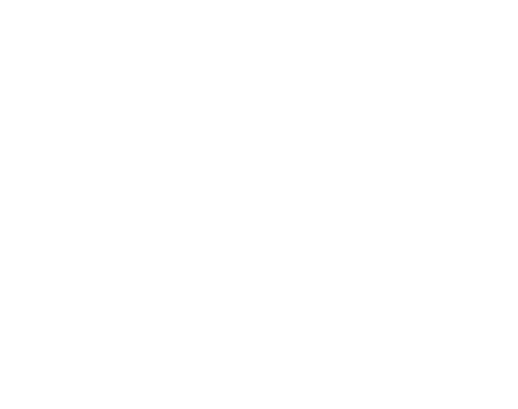
Figure 7. Spearman rank correlations between different parameters of behavioral taste responses to pellets of agar gel flavored with amino acids observed in barramundi Lates calcarifer . C—pellets consumption; F—pellets fragmentation; G—number of pellet grasps; t and T: pellet retention times for the first grasp and for all grasps over the entire trial, respectively. *** p < 0.001.